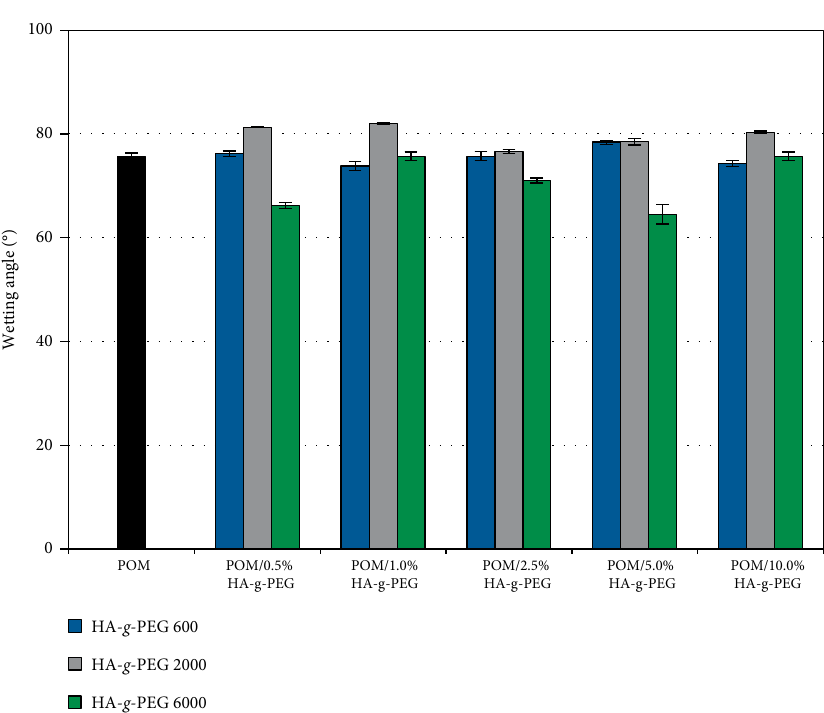
Figure 9: Wetting angle of POM/HA- g -PEG